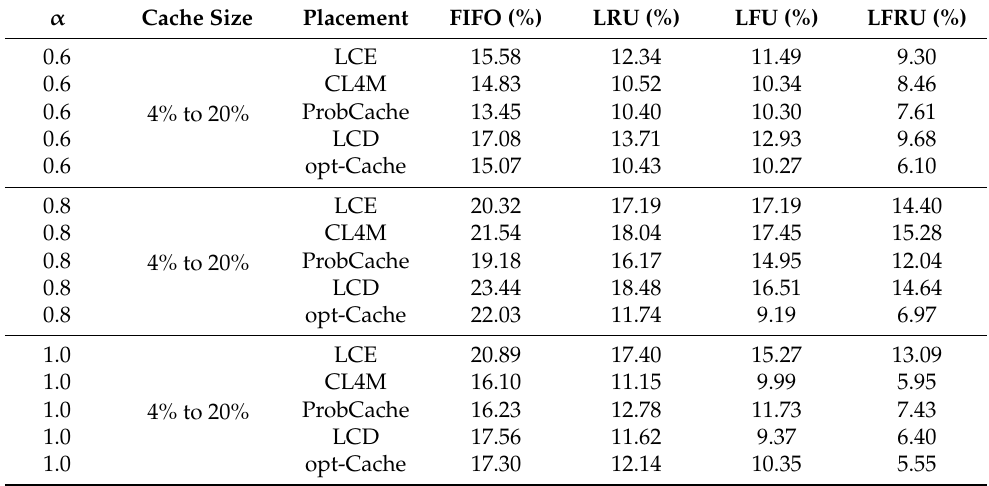
Table 13. IMU link load percentage